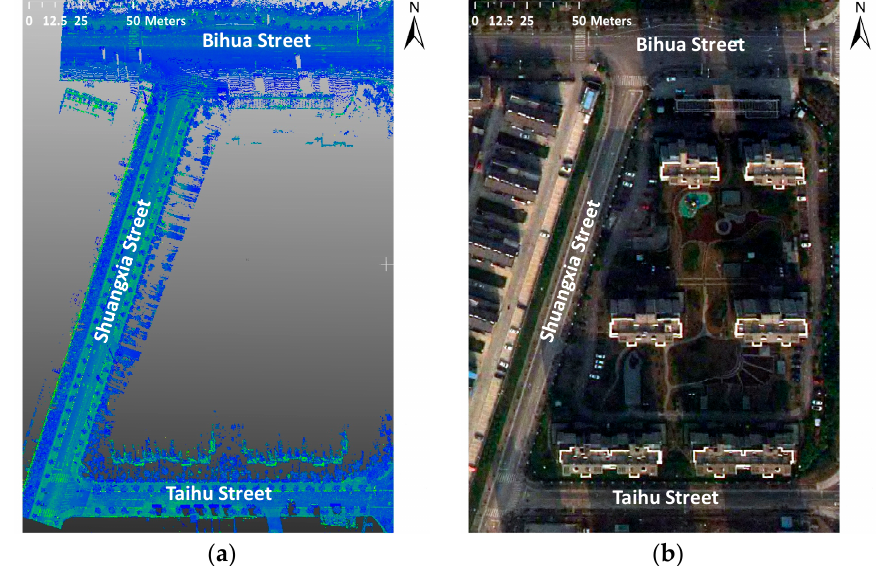
Figure 1. Study area in Nantong City. ( a ) Point cloud data; ( b ) Aerial image.